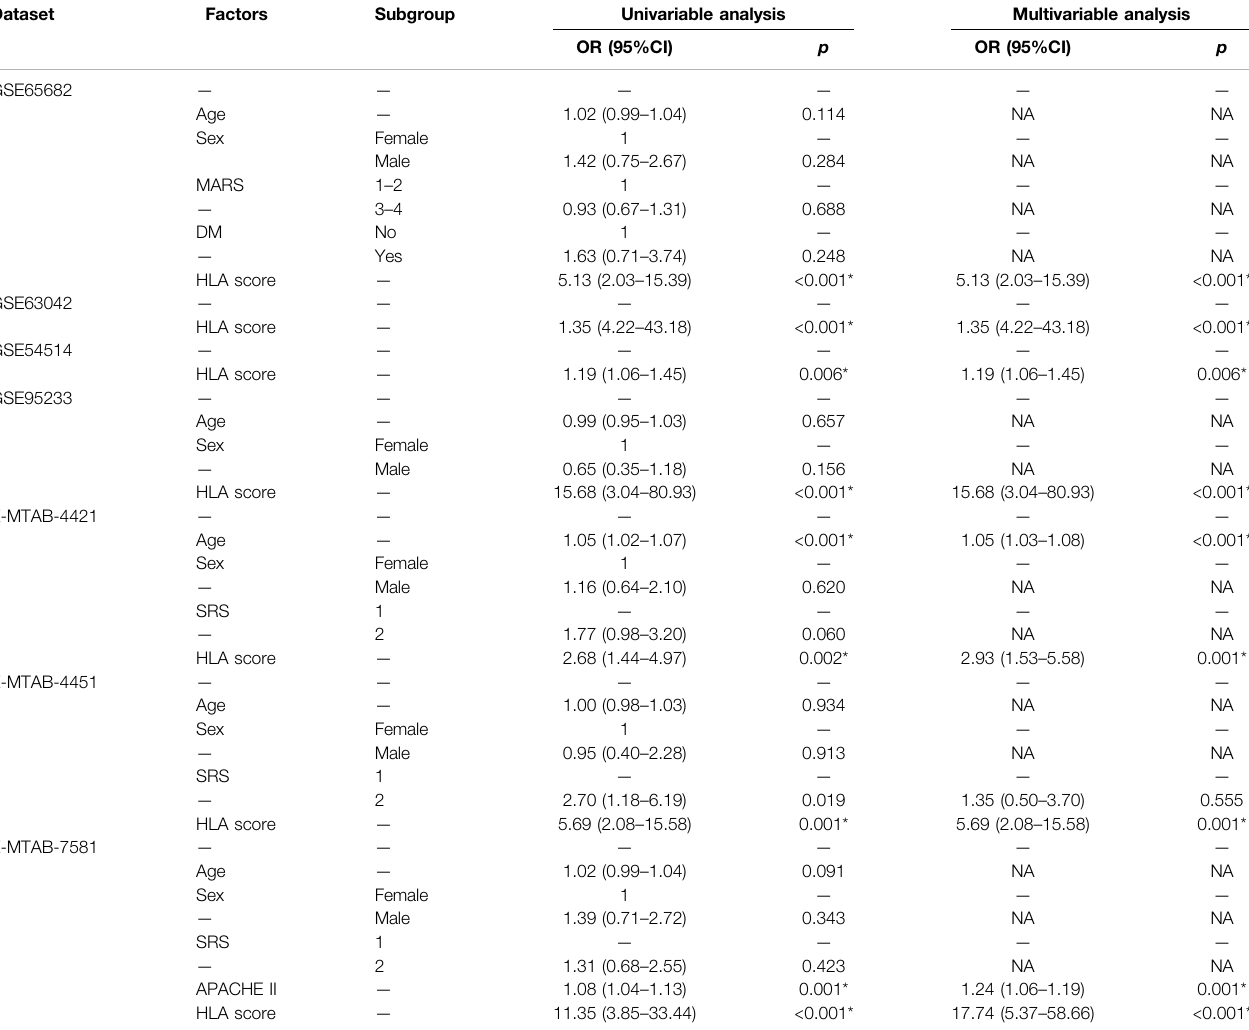
TABLE 2 | Univariable and multivariable logistic regression analysis for prediction of survival in GEO and ArrayExpress databases.